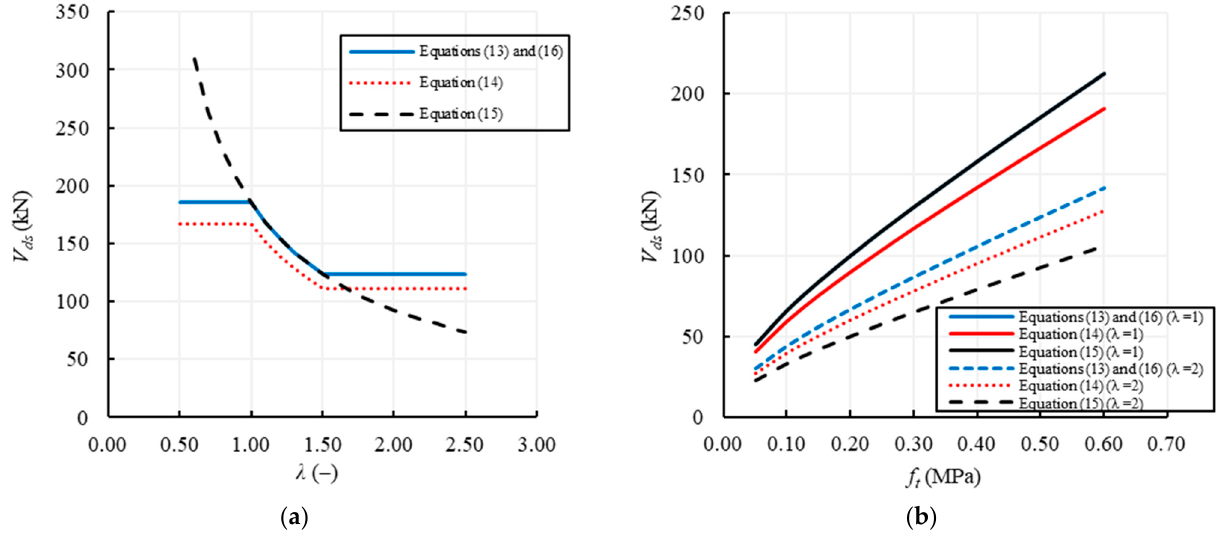
Figure 10. Sensitivity analysis of the shear formulations for irregular/rubble masonry in function of: ( a ) wall slenderness, λ , for f t = 0.5 MPa; ( b ) tensile strength of masonry, f t , in the case of λ = 1.0 and 2.0.